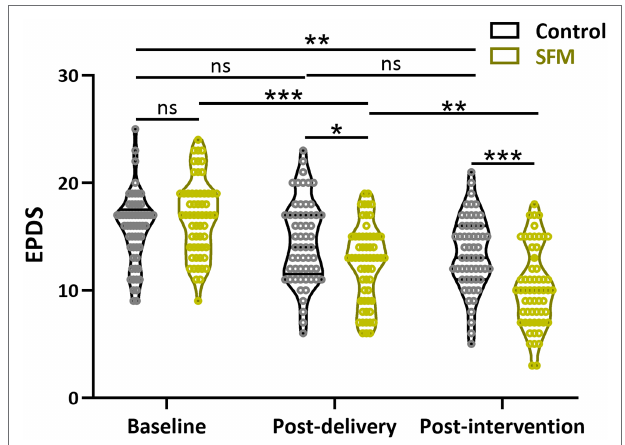
(EPDS) was used to diagnose the postpartum depression when the score ≥ 13. SFM, solution-focused model.